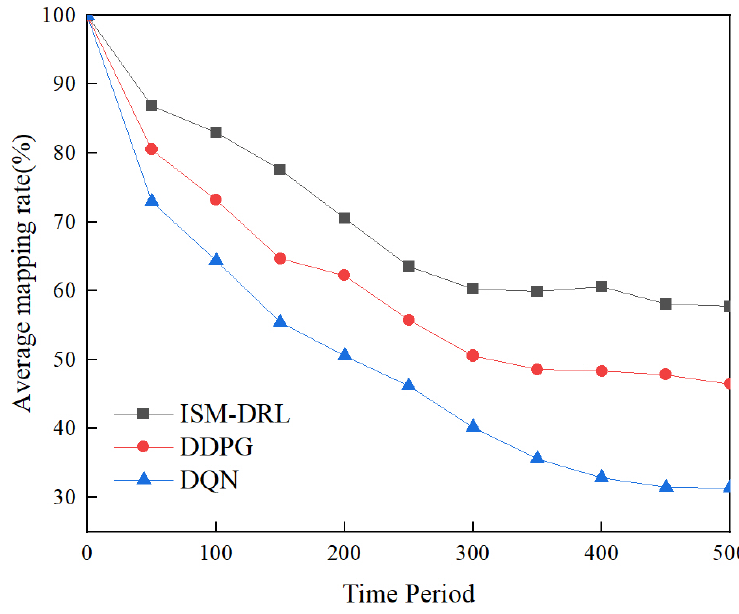
Figure 8. Average mapping rate at α 1 = 0.7, α 2 =